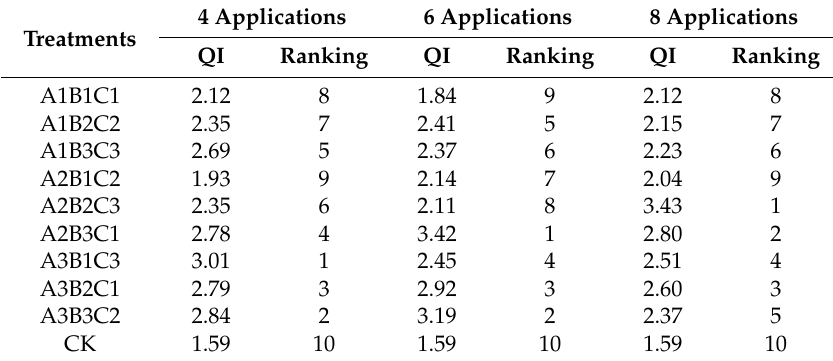
Table 14. Seedling quality index in each treatment.